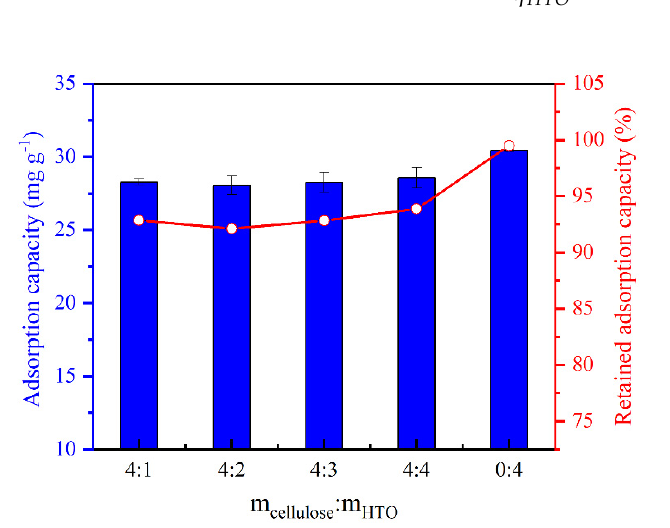
Figure 6. Li + adsorption capacity of HTO/CA with different HTO loadings and respective % q e retained by HTO in CA for Li + (pH = 10.25; V = 160 mL; m ≅ 100 mg; C 0 = [Li + ] ≅ 50 mg L − 1 ).